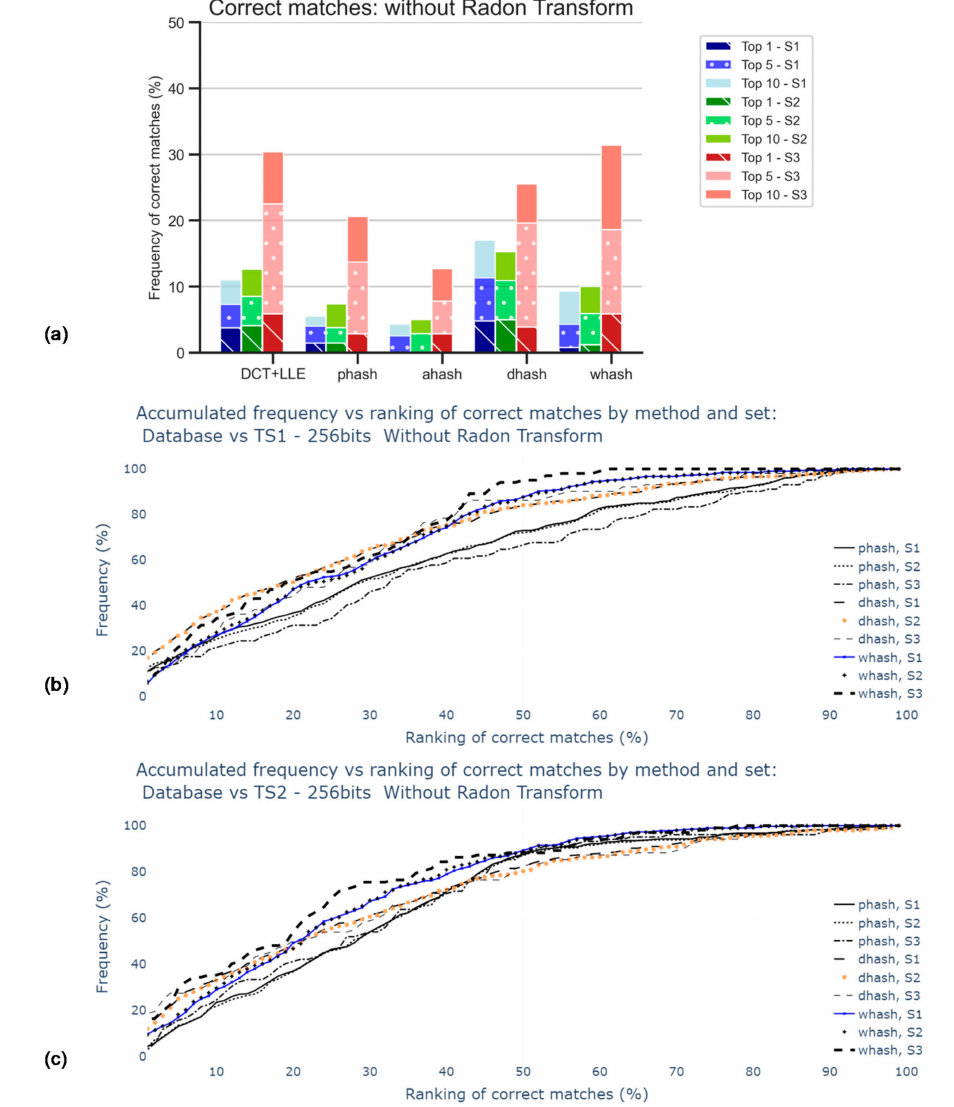
Figure 8. Percentage of correct matches without the application of Radon transform nor contrast stretching: ( a ) for the worst cases between TS1 and TS2 comparisons and only for top 1, top 5, and top 10; ( b ) for the comparison with TS1, all rankings (in percentage); ( c ) for the comparison with TS2, all rankings (in